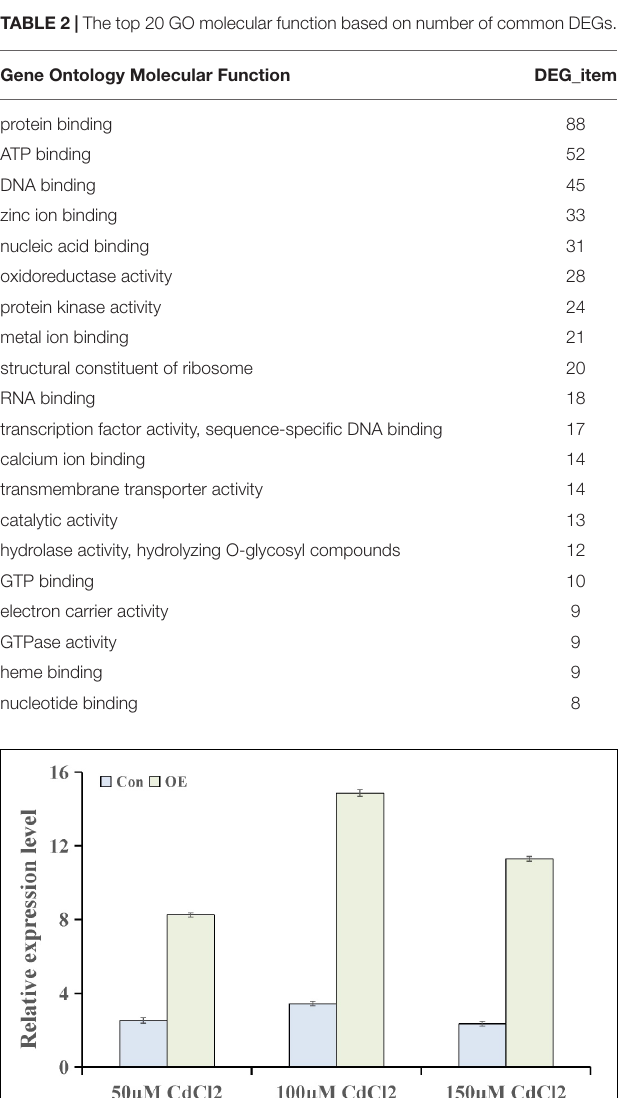
6,778 DEGs were detected at 24 h and then increased to 8,282